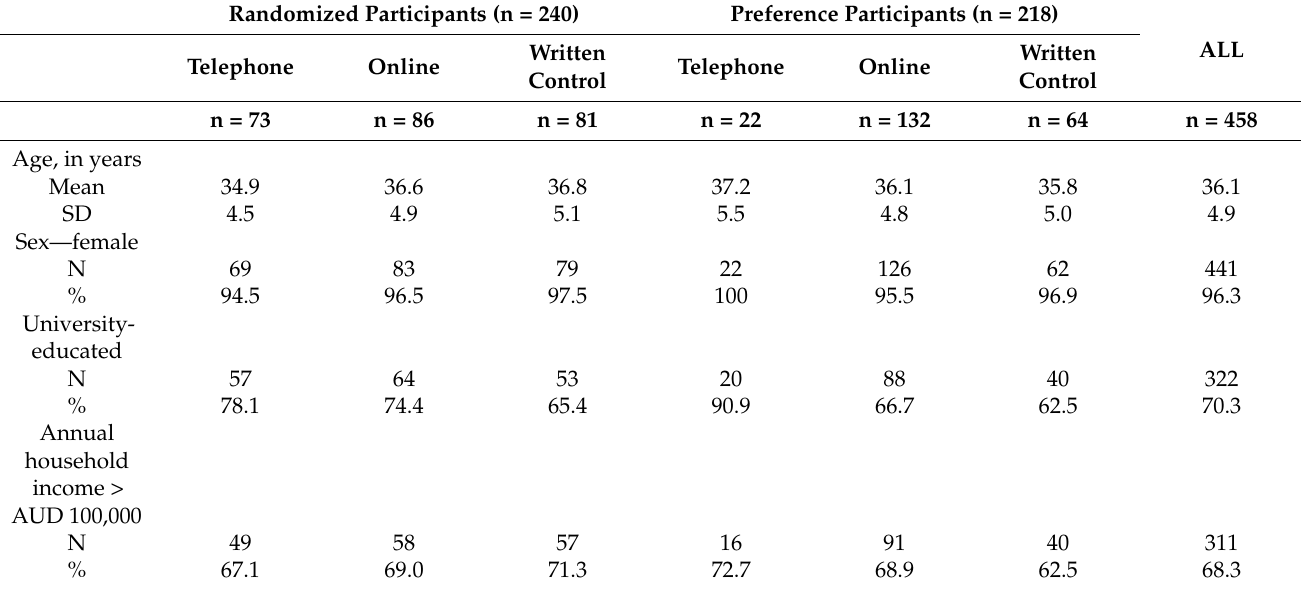
Table 2. Parent characteristics at baseline